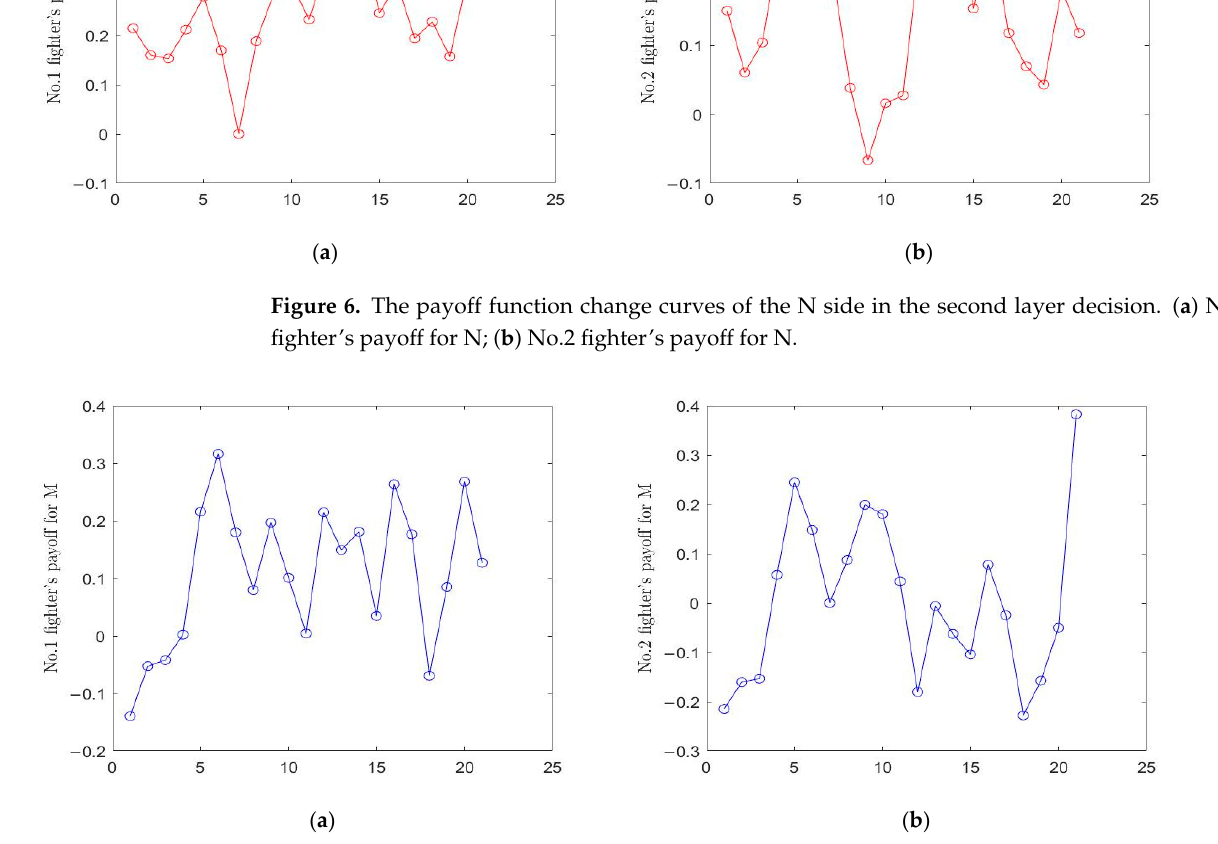
Figure 7. The payoff function change curves of the M side in the second layer decision. ( a ) No.1 fighter’s payoff for M ; ( b ) No.2 fighter’s payoff for M. Table 6. Results of maneuver decisions.